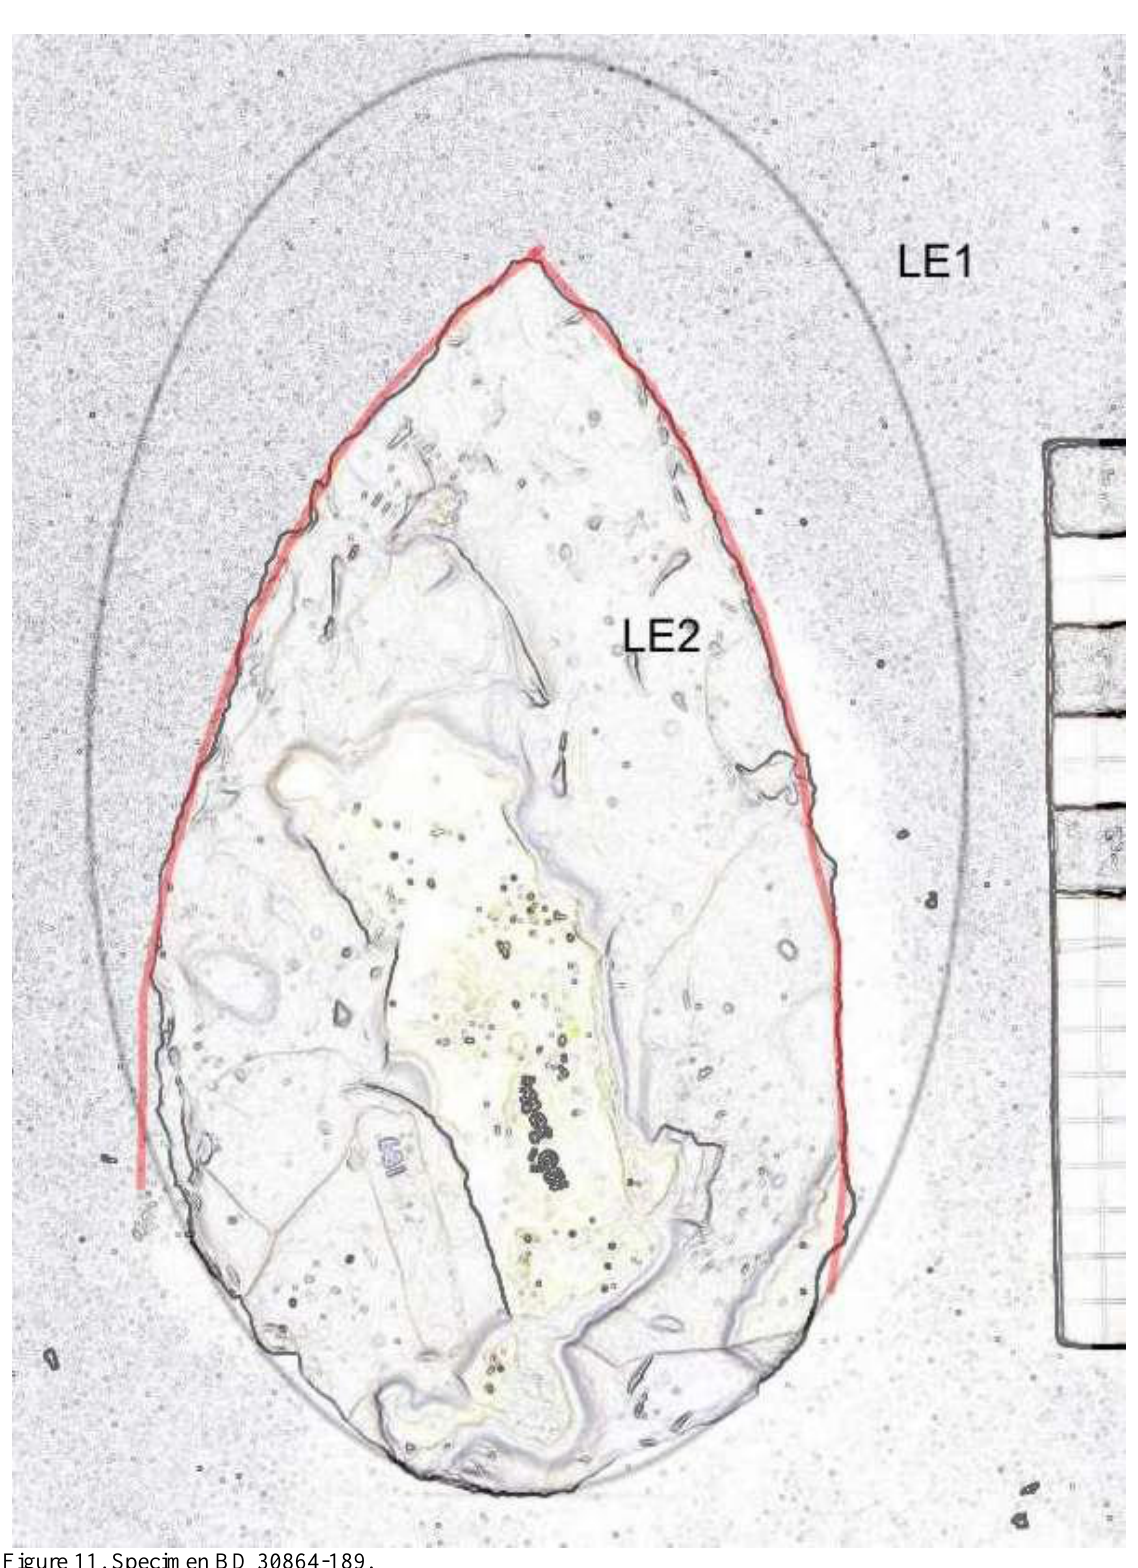
Figure 11. Specimen BD